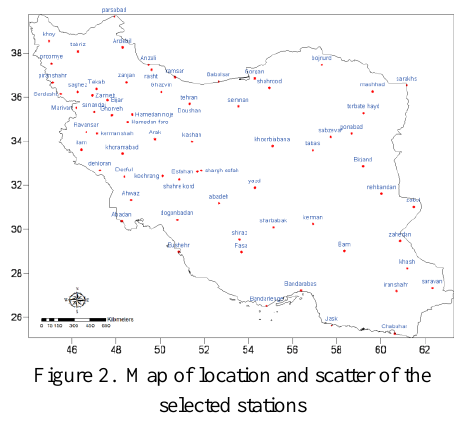
Figure 2. Map of location and scatter of the selected